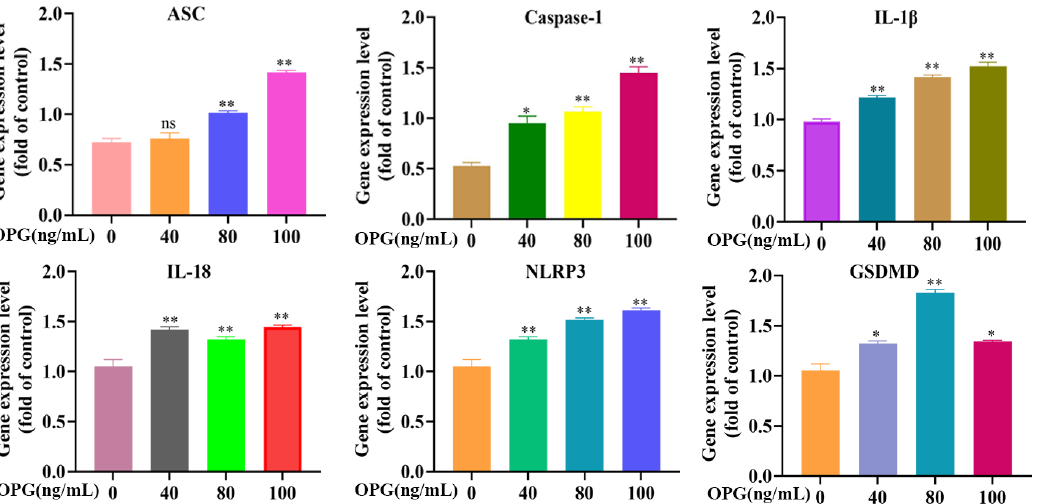
Figure 3. Effect of OPG on transcription levels of pyroptosis pathway-related genes of osteoclasts. ASC, Caspase-1, IL-18, IL- 1β, NLRP3, and GSDMD were quantified by q -PCR. (mean ± SD, n = 3, * p < 0.05, ** p < 0.01).